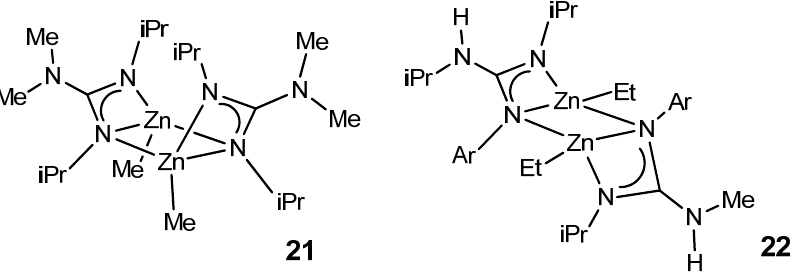
Figure 14. Guanidinato ligands acting both as chelate ligands and as a bridge between two zinc nuclei with boat and chair conformations.